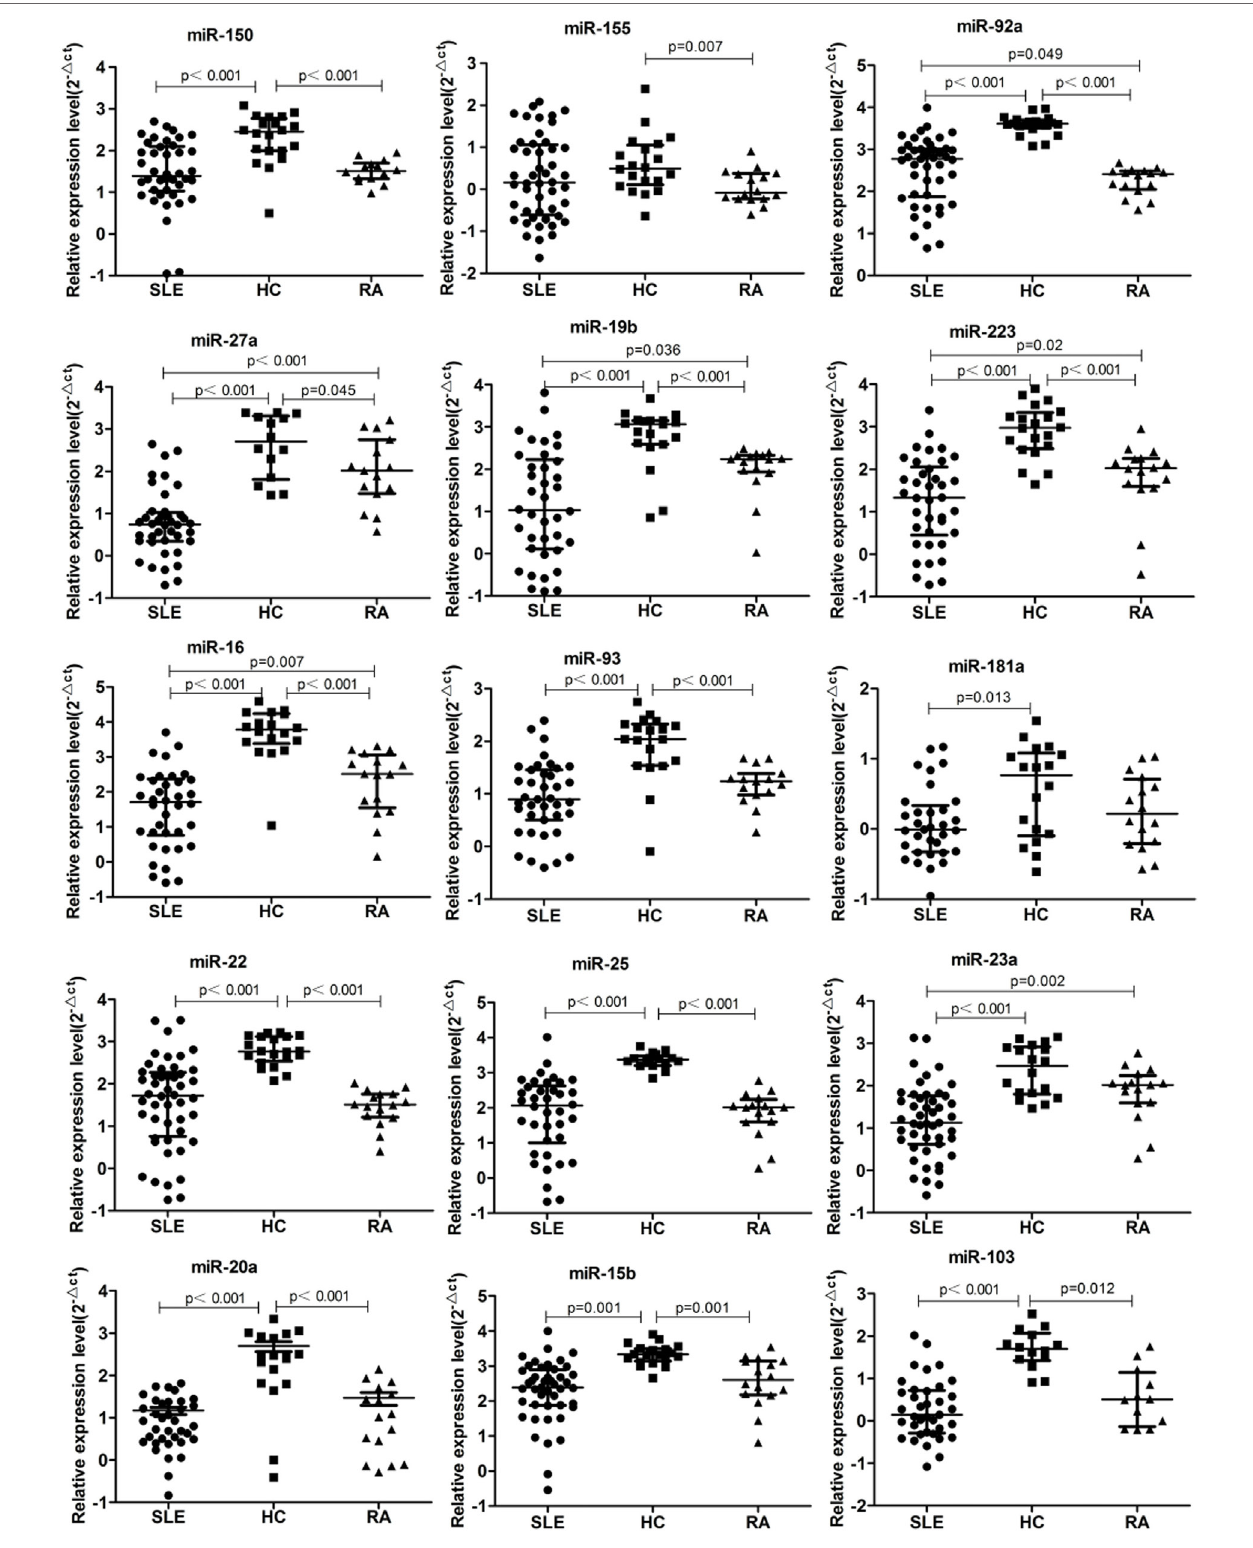
FigUre 2 | 15 microRNA (miRNA) differentially expressed in the plasma of systemic lupus erythematosus (SLE), rheumatoid arthritis (RA) patients, and healthy control (HC). Expressions of the selected miRNAs in the plasma obtained from patients with SLE ( n = 50), RA ( n = 16), and HC ( n = 20) were determined by qRT-PCR. The expression levels of miRNAs were normalized to cel-miR-39.